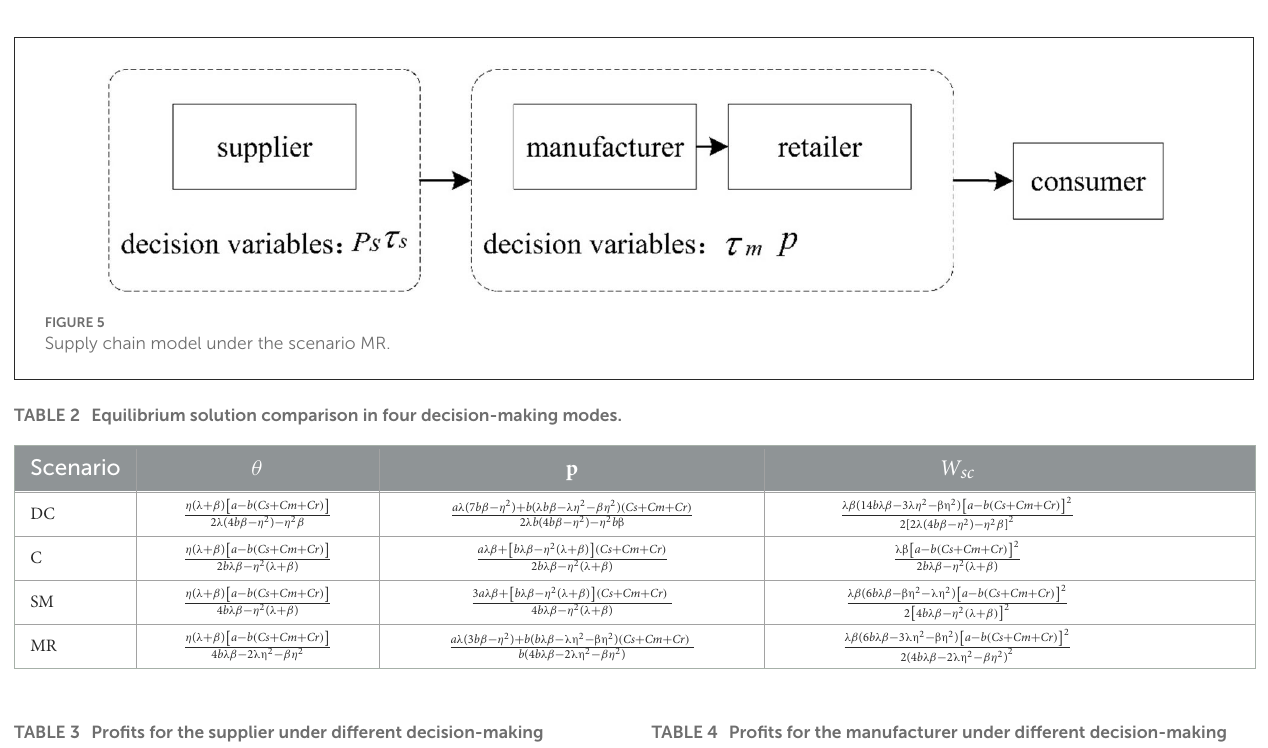
TABLE 3 Profits for the supplier under different decision-making scenarios. Scenario